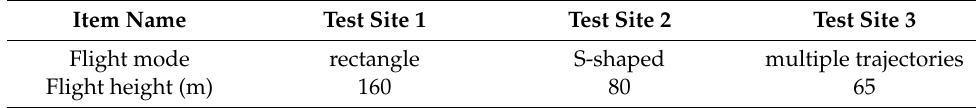
Table 1. Details of the three test